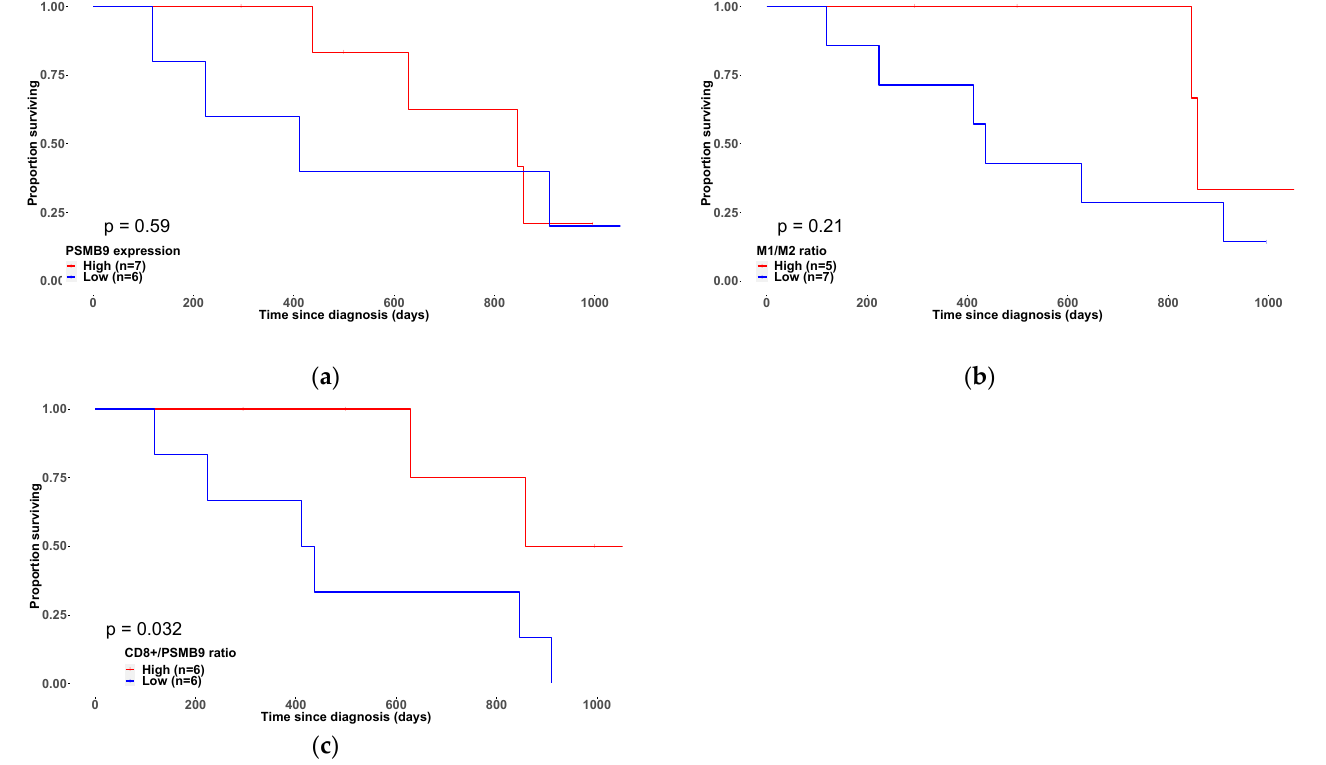
Figure 6. ( a ). 3-year OS of patients grouped based on PSMB9 gene expression p = 0.59). ( b ). 3-year OS of patients grouped based on M1/M2 ratio ( p = 0.21). ( c ) 3-year OS of patients based on CD8+/PSMB9 ratio ( p = 0.032).